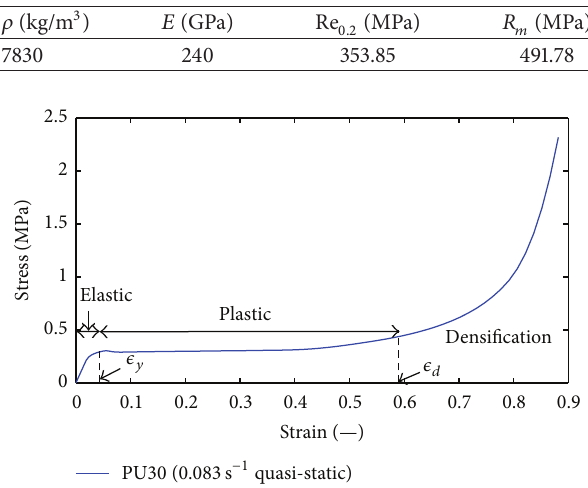
Figure 1: Stress-strain response of the closed-cell polyurethane PU30 under quasi-static compression